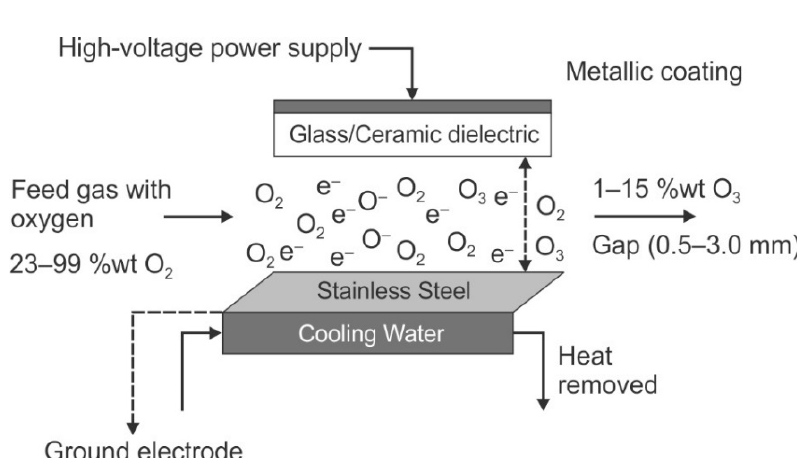
Figure 10. Cross section schematic of an ozone generator. Reprinted with permission of John Wiley & Sons